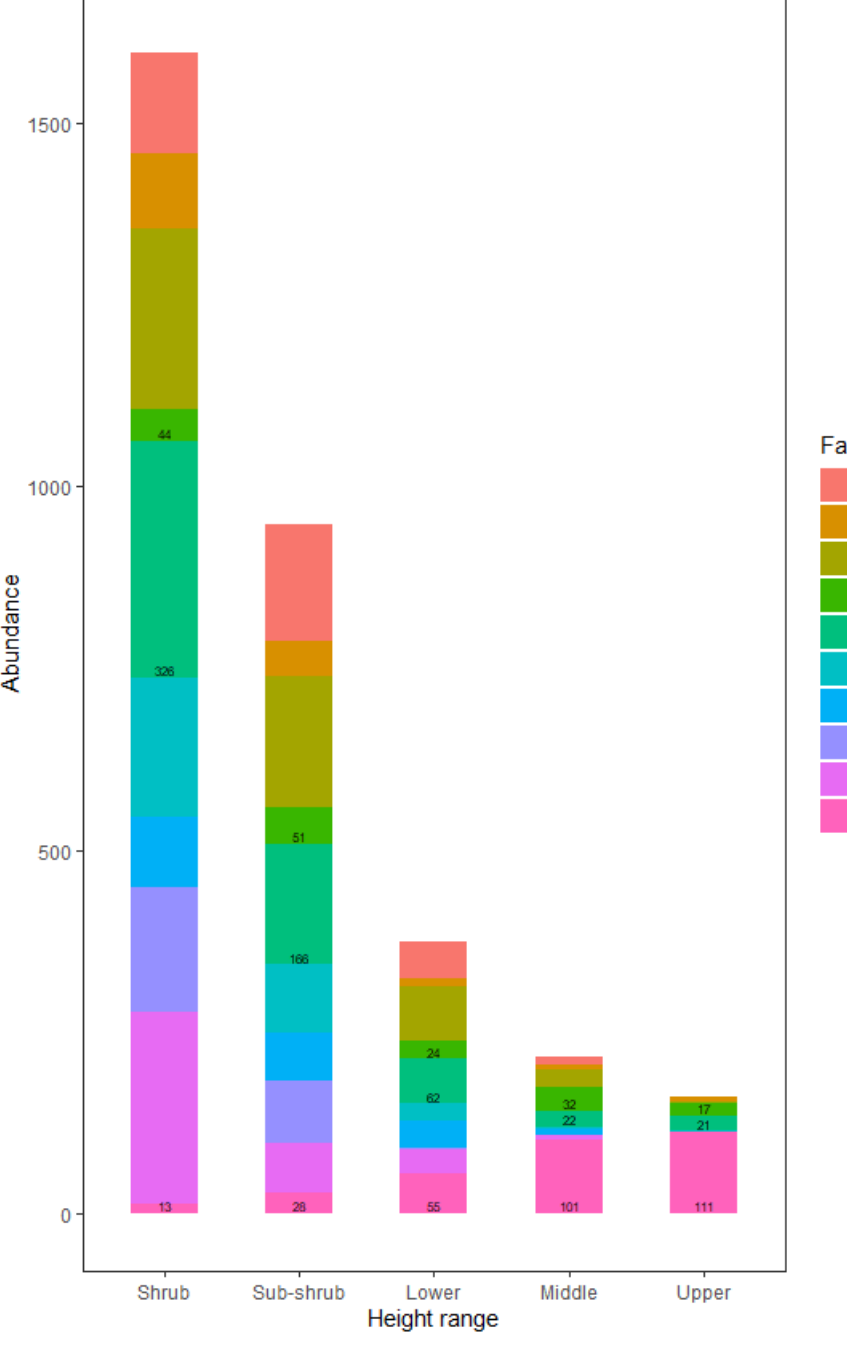
Figure A2. Abundance of each family among the top 10 largest families in different height ranges. Only Lauraceae, Theaceae, and Fagaceae were distributed in all five height ranges, with an abundance >10 in each height range, among the top 10 largest families in the community. The abundance of Lauraceae was 326, 166, 62, 22, and 21 in shrub, sub-shrub, lower, middle, and upper canopies, respectively. The abundance of Theaceae was 13, 26, 55, 101, and 111, respectively, and the abundance of Fagaceae was 44, 51, 24, 32, and 17, respectively. The five height ranges were shrub canopy (1.4 – 4 m); sub-shrub canopy (4 – 6.8 m); lower canopy (6.8 – 11.3 m); middle canopy (11.3 – 17.4 m); upper canopy (17.4 – 27.1 m).